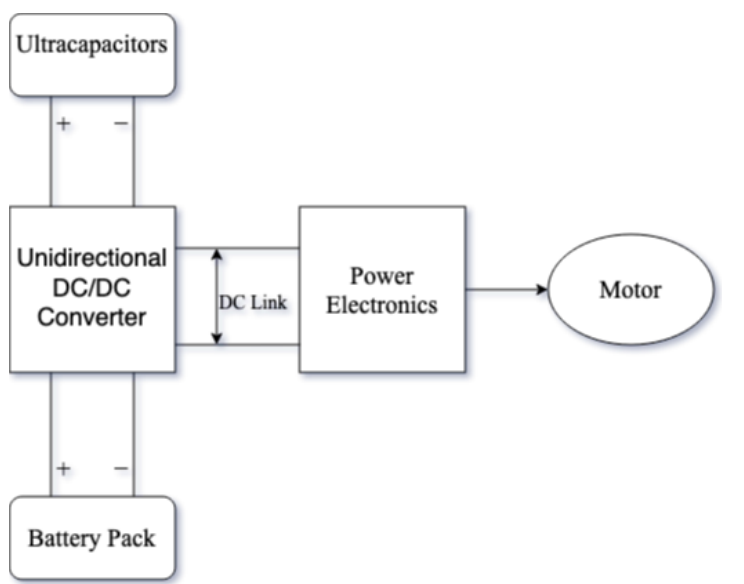
Figure 11. Common topology for the hybrid energy system consisting of batteries and ultracapaci- tors.